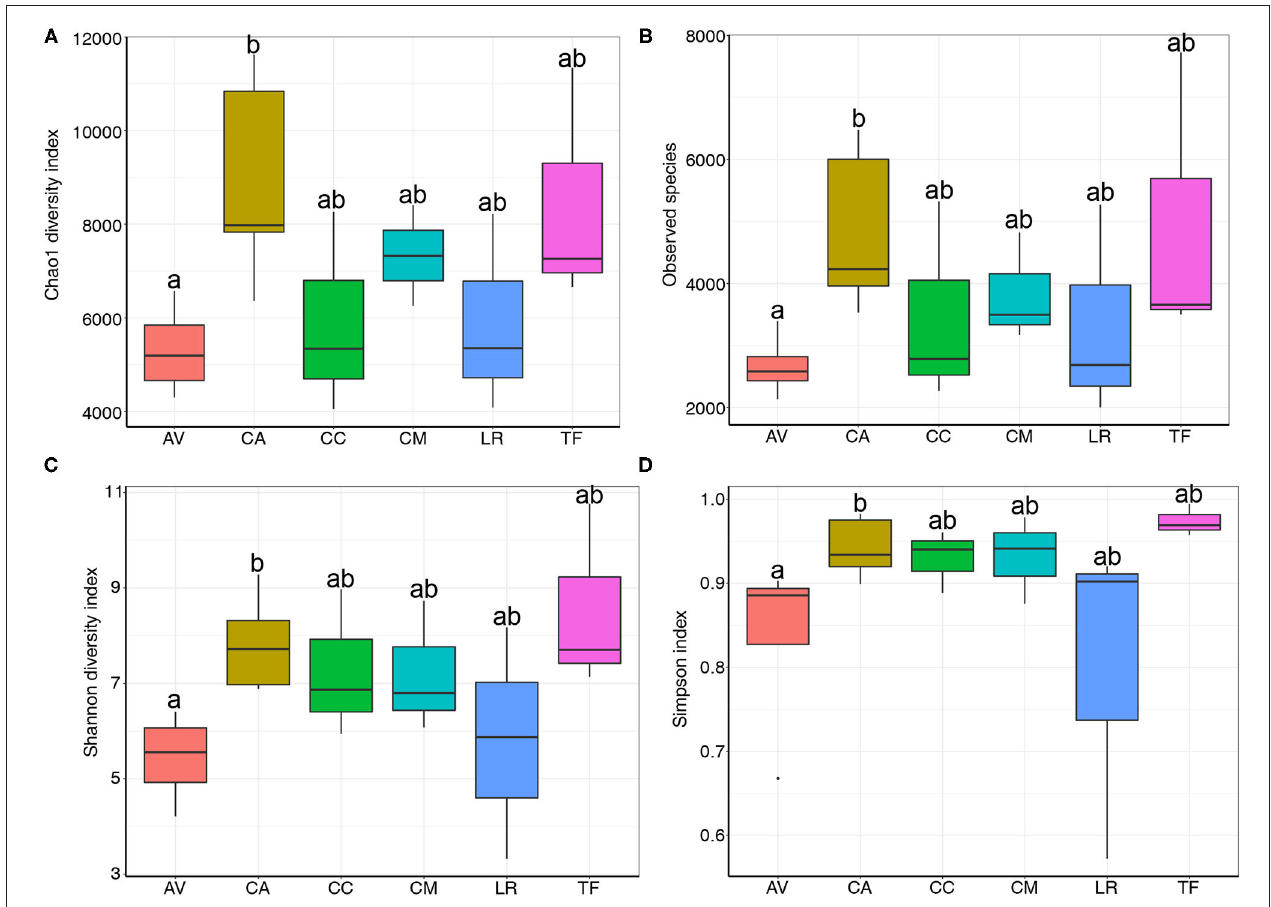
FIGURE 2 | Chao1 diversity (A) , observed species (B) , Shannon diversity (C) and Simpson indices (D) of bacterial populations in each sample. AV, demoiselle crane ( Anthropoides virgo ); CA, black swan ( Cygnus atratus ); CC, whooper swan ( Cygnus cygnus ); CM, muscovy duck ( Cairina moschata ); LR, relict gull ( Larus relictus ); TF, ruddy shelduck ( Tadorna ferruginea